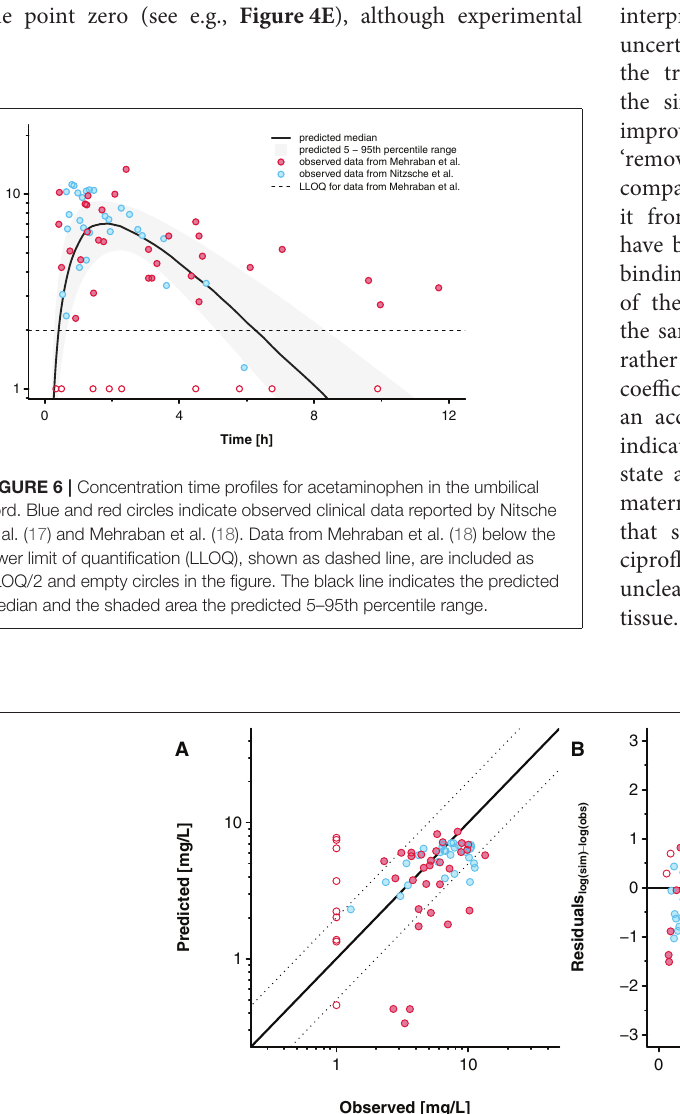
Frontiers in Pediatrics |